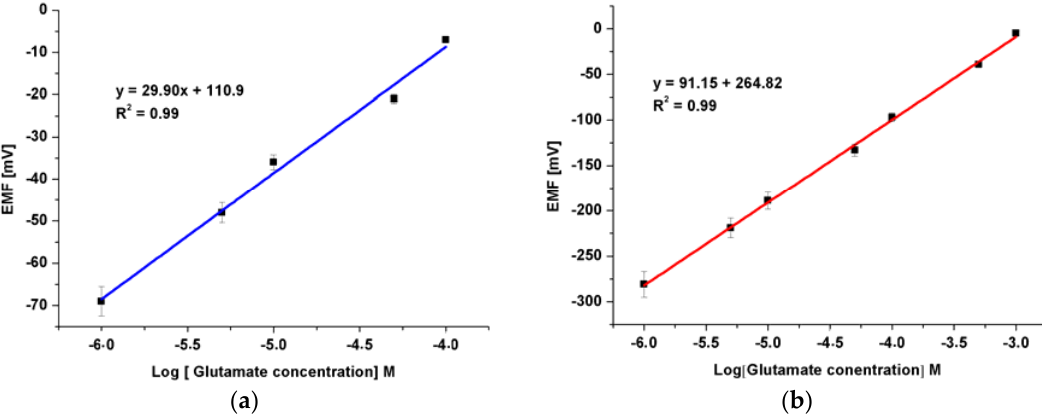
Figure 7. The calibration curve of the fabricated Glu biosensor based on ZNRs grown ( a ) without EG and ( b ) with 0.1%(w/v) of EG , more than six sensor electrodes have been investigated using the same set of conditions and the same functionalized membrane.